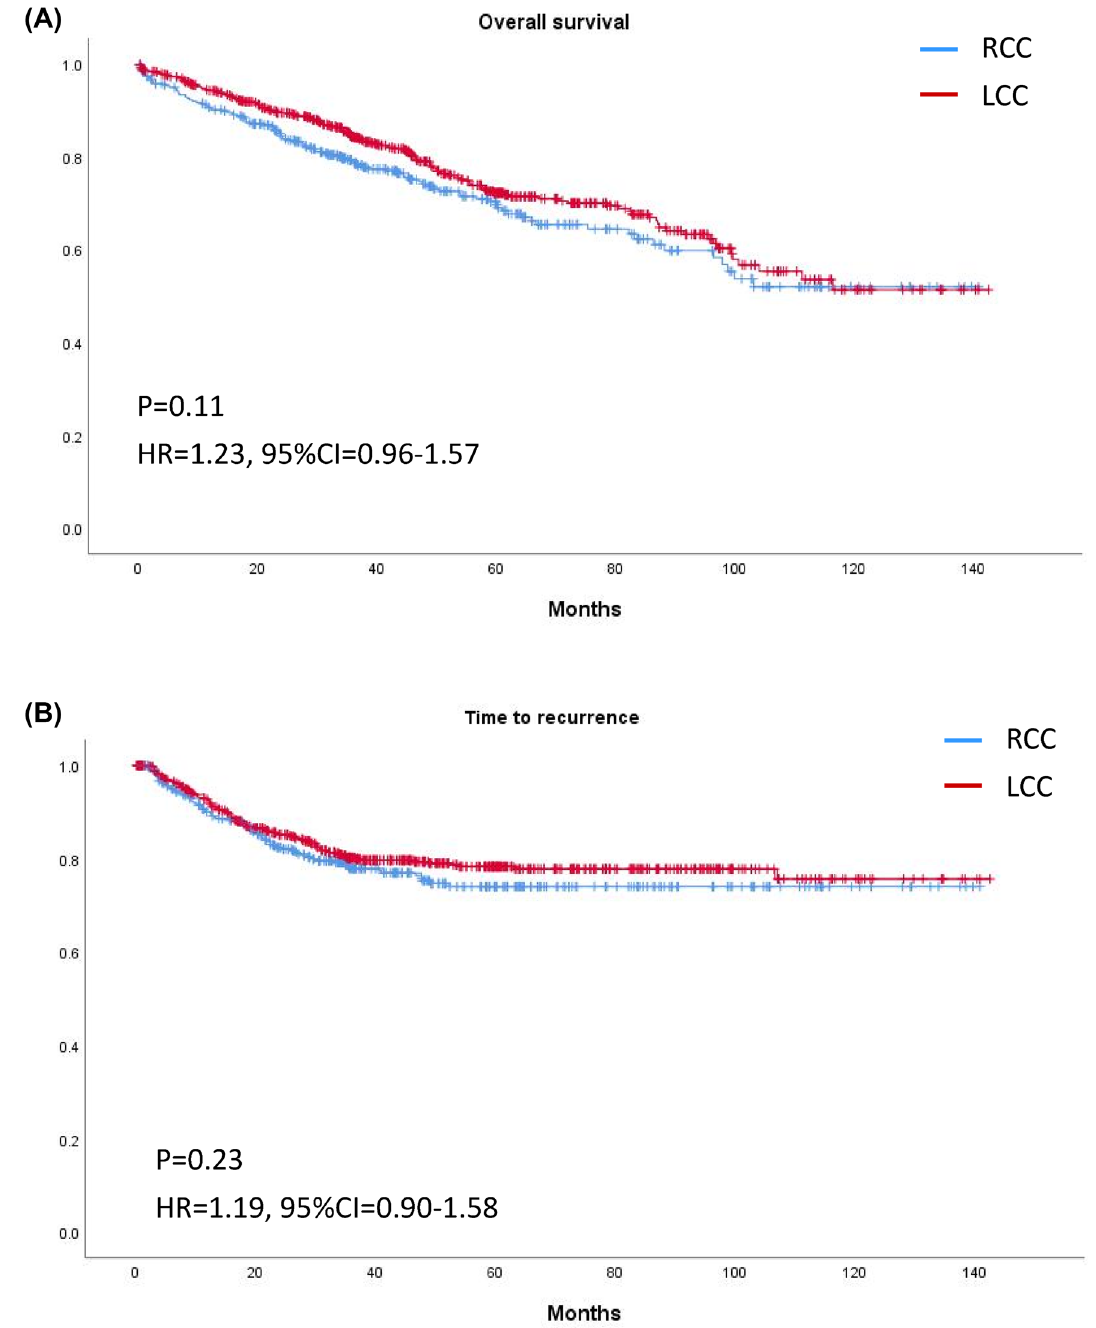
Figure 2. Kaplan–Meier curves of ( A ) overall survival and ( B ) time to recurrence of right-sided and left-sided colon cancer of any